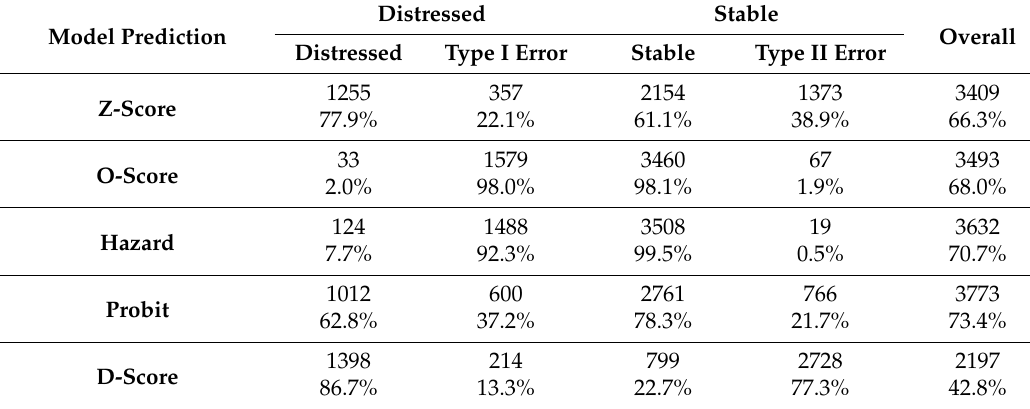
Table 5. Prediction accuracy of